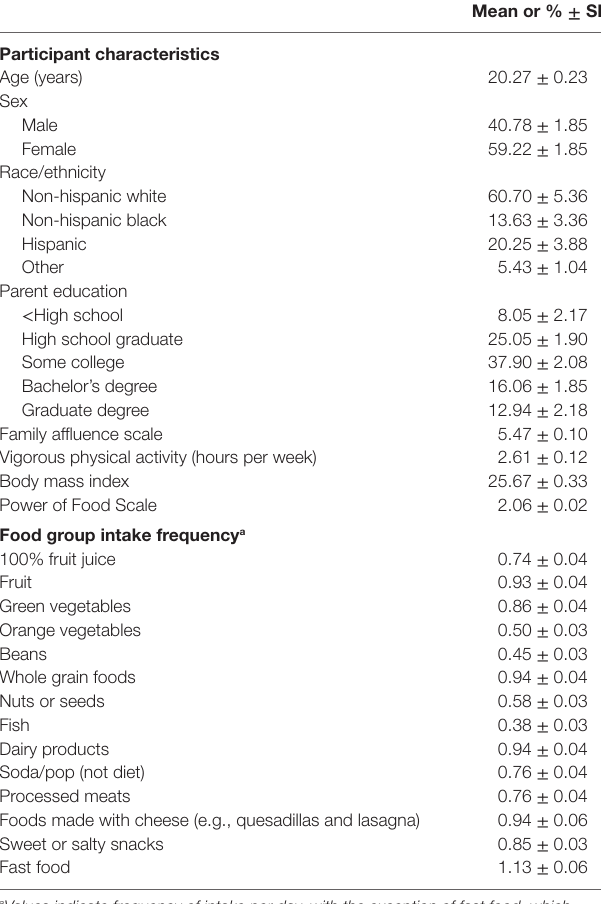
TaBle 1 | Weighted sample characteristics of the neXT generation health study at wave